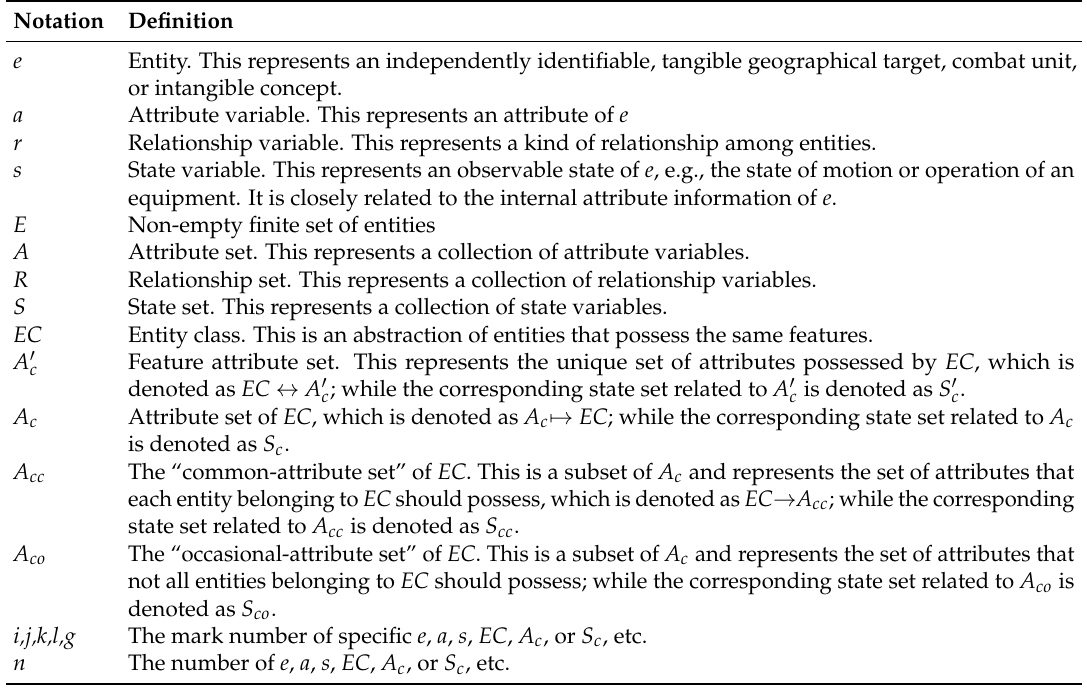
Table 1. A list of major